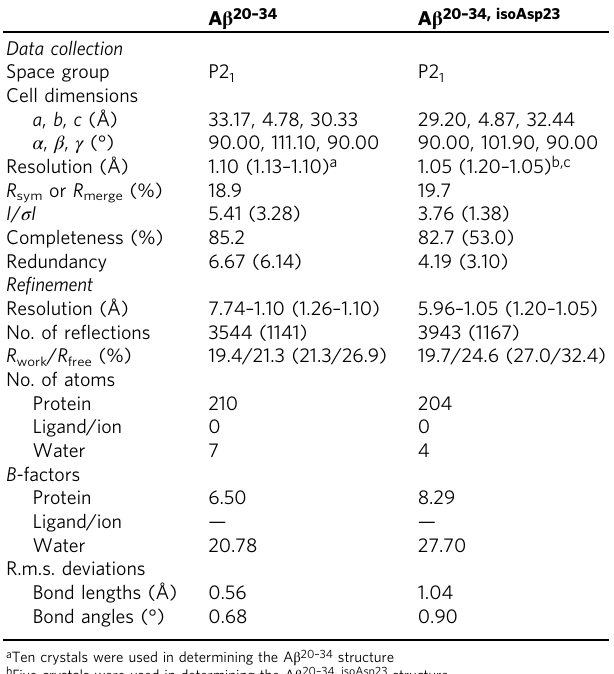
Table 1 Data collection and re fi nement